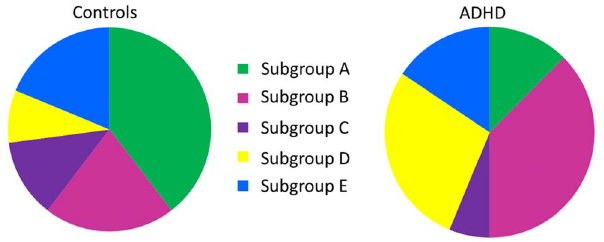
Figure 7. Subgroup make-up: Controls and ADHD.